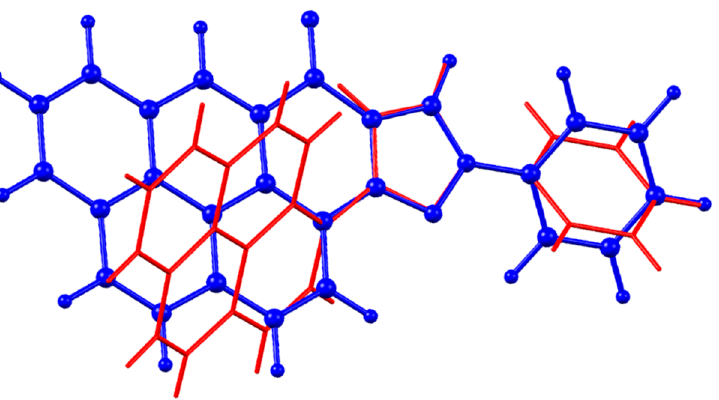
found to be planar (Figure 4 and Supplementary Information).